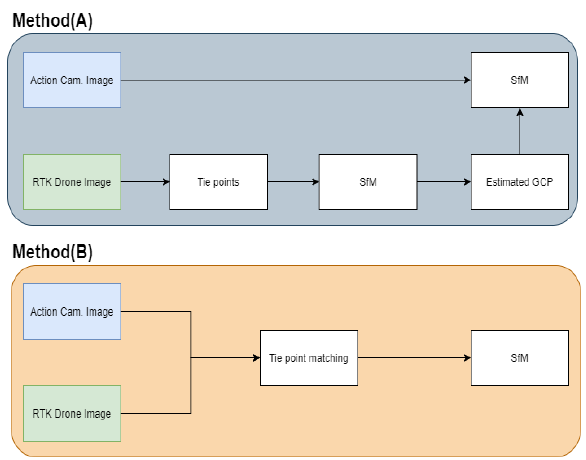
Figure 3. Workflow of method (A) and